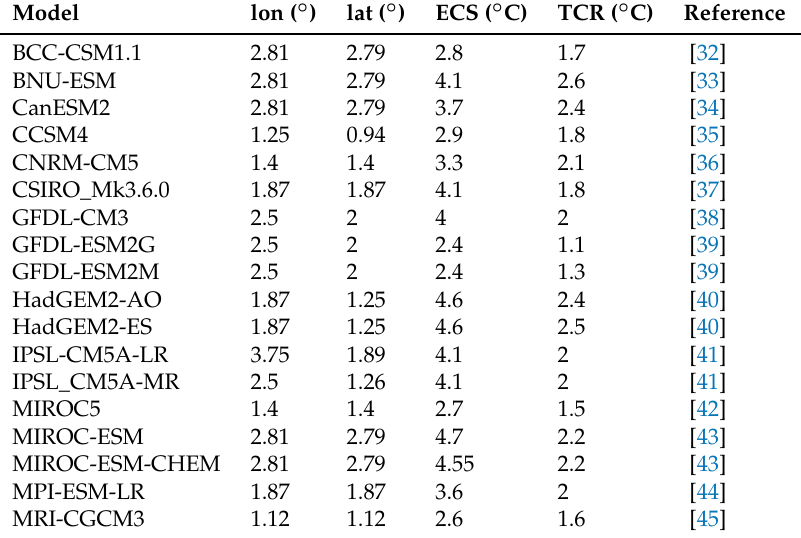
Table 1. Set of 18 CMIP5 global models with their respective horizontal resolution, Equilibrium Climate Sensitivity (ECS) and Transient Climate Response (TCR) for CO 2